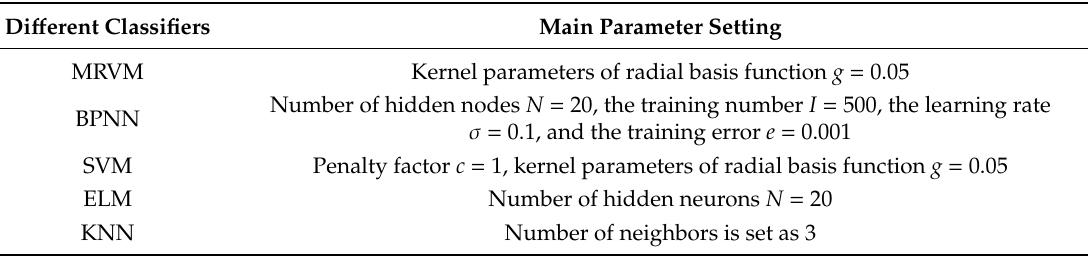
Table 6. Main parameter setting of various classifiers.